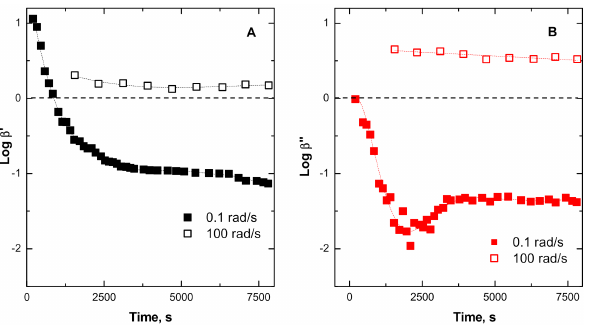
Figure 11. Plots of β ’ and β ” as a function of thermal treatment